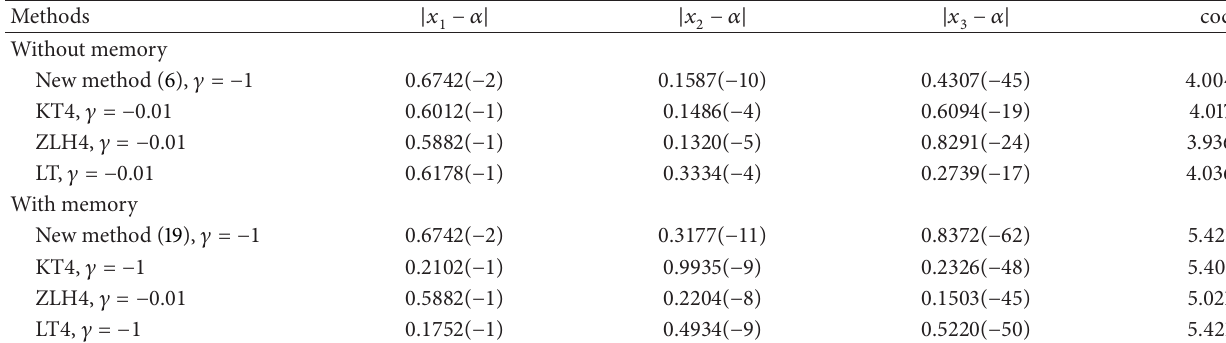
Table 1: 𝑓 1 (𝑥) = sin (𝜋𝑥)𝑒 (𝑥